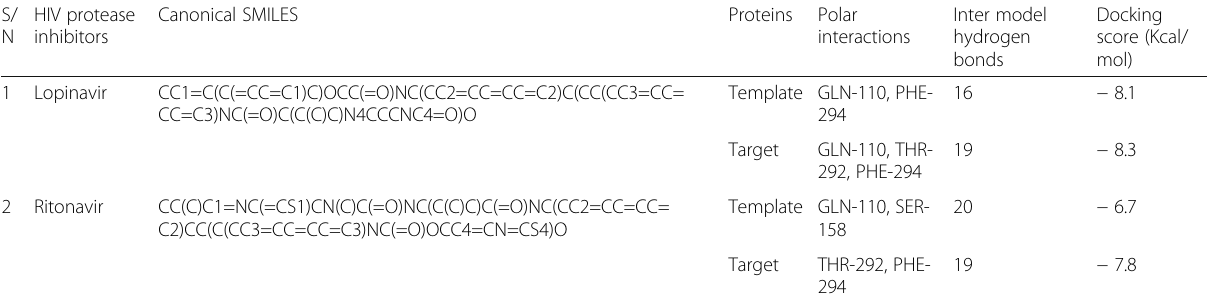
Table 5 Here, the docking results of lopinavir and ritonavir against the template and target protein are shown. The binding of ritonavir to the template protein produced the highest number of inter model hydrogen bonds while the binding of lopinavir to the target protein formed polar interaction with three residues at the active site as compared to the two formed by the other interactions